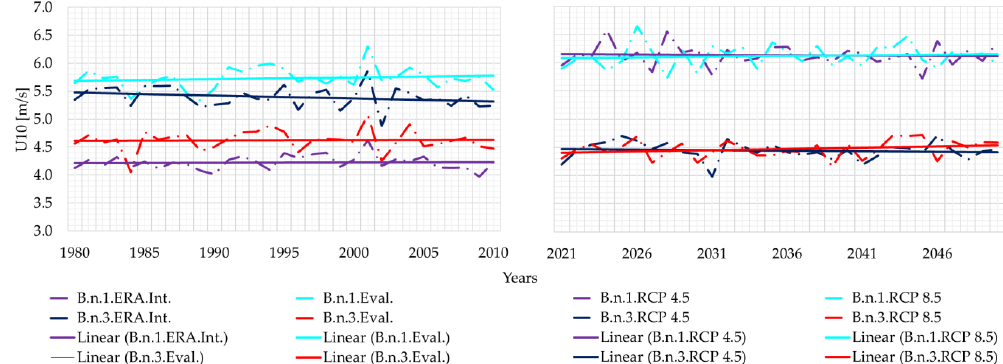
Figure 3. Annual averages of the wind speed at 10 m height for two of the most representative points located in the Romanian nearshore of. ERA.Int and Eval data, time interval 1981–2010, RCP4.5 and RCP8.5 data, time interval 2021–2050.